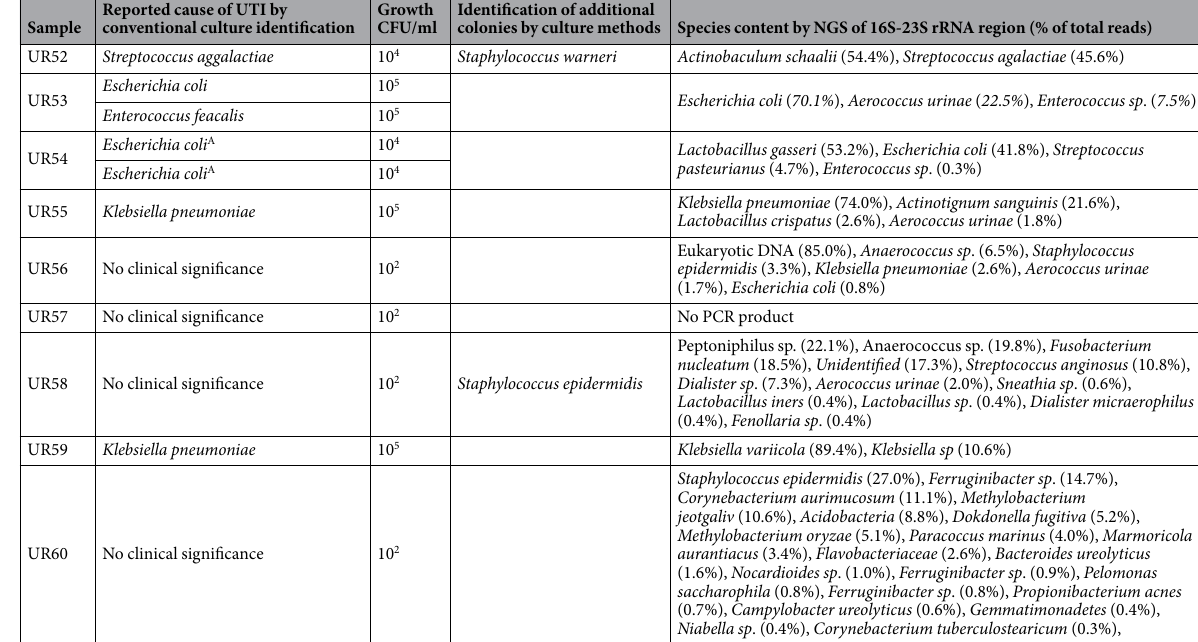
Table 1. Bacterial identification results from 60 urine samples based on culture and NGS of 16S-23S rRNA region. A Stains revealed different resistance